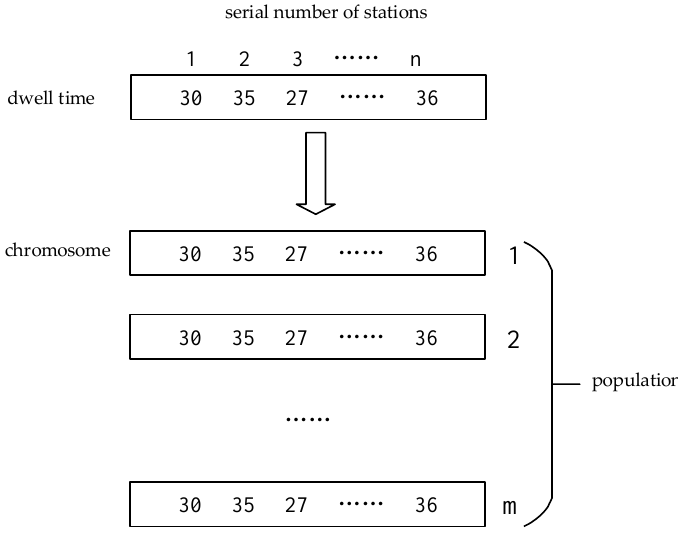
Figure 12. Initial population of dwell time.